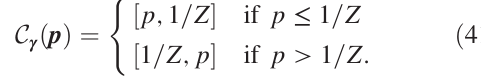
FIG. 6. Quantum advantage at infinite temperature for d ¼ 3 . We showthesetsofstates accessibleviaclassical[ C η ð p Þ ,smallerorange shape] and quantum [ Q η ð p Þ , larger blue hexagon] memoryless dynamics with a uniform fixed point η for a system of dimension d ¼ 3 and an exemplary initial state p (each point inside a triangle corresponds to a probabilistic mixture of sharp distributions). The set C η ð p Þ was constructed using the results of Ref.